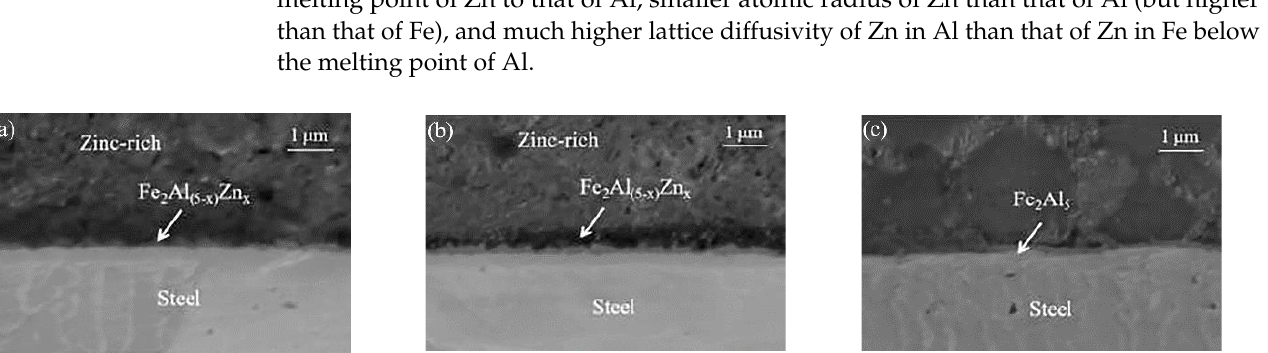
Figure 18. High magnification microstructure images of Al-to-DX56-Z joints from the center of reaction layers at the interface of the steel sheet [3]: ( a ) 0.5 s; ( b ) 2.0 s; ( c ) 3.0 s.